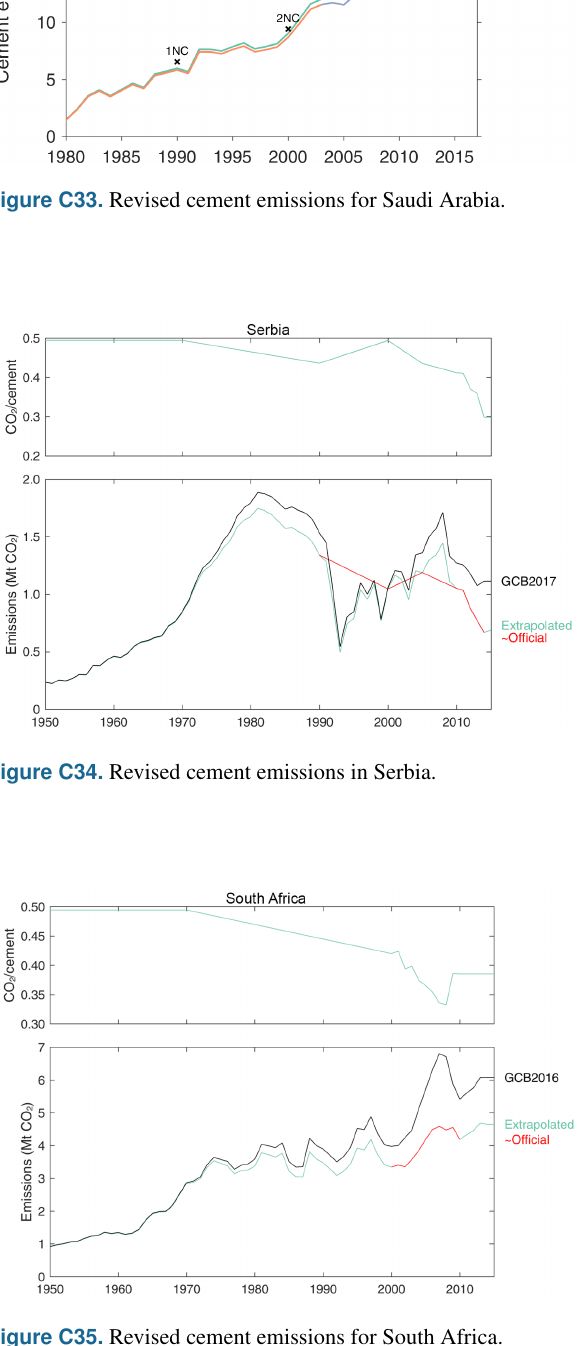
Figure C35. Revised cement emissions for South